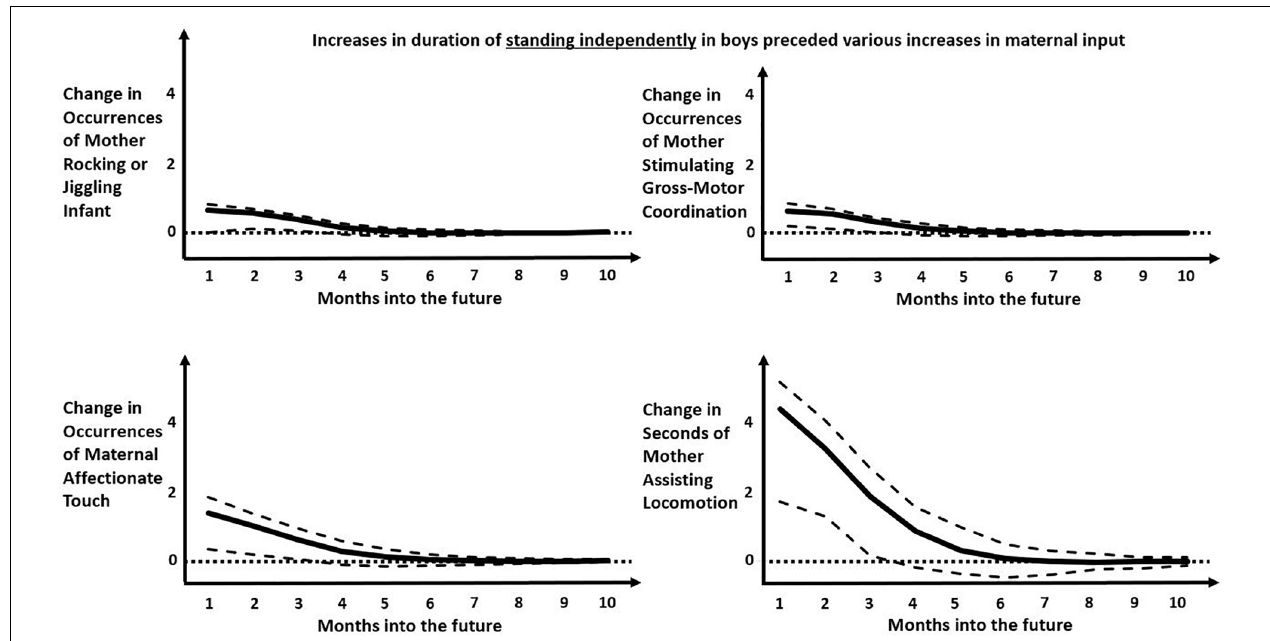
FIGURE 4 | Impulse-response functions modeling the predicted later increase in various maternal behaviors following an increase in occurrences of boys standing independently. Solid black curve represents the average IRF values over months into the future. Dashed lines represent the upper and lower bounds of the 95% confidence interval. Dotted lines represent zero-change. Predicted occurrence of “mother rocking or jiggling infant” increased 2–3 months into the future (top left). Predicted occurrence of “mother stimulating gross-motor coordination” increased 1–2 months into the future (top right). Predicted occurrences of “maternal affectionate touch” increased 1–2 months into the future (bottom left). Predicted occurrences of “mother assisting locomotion” increased 1–3 months into the future. Note that, although all predicted later changes are positive and significant over the first few months, the predicted later effects in the top two panels are much smaller than the predicted later effects in the bottom two